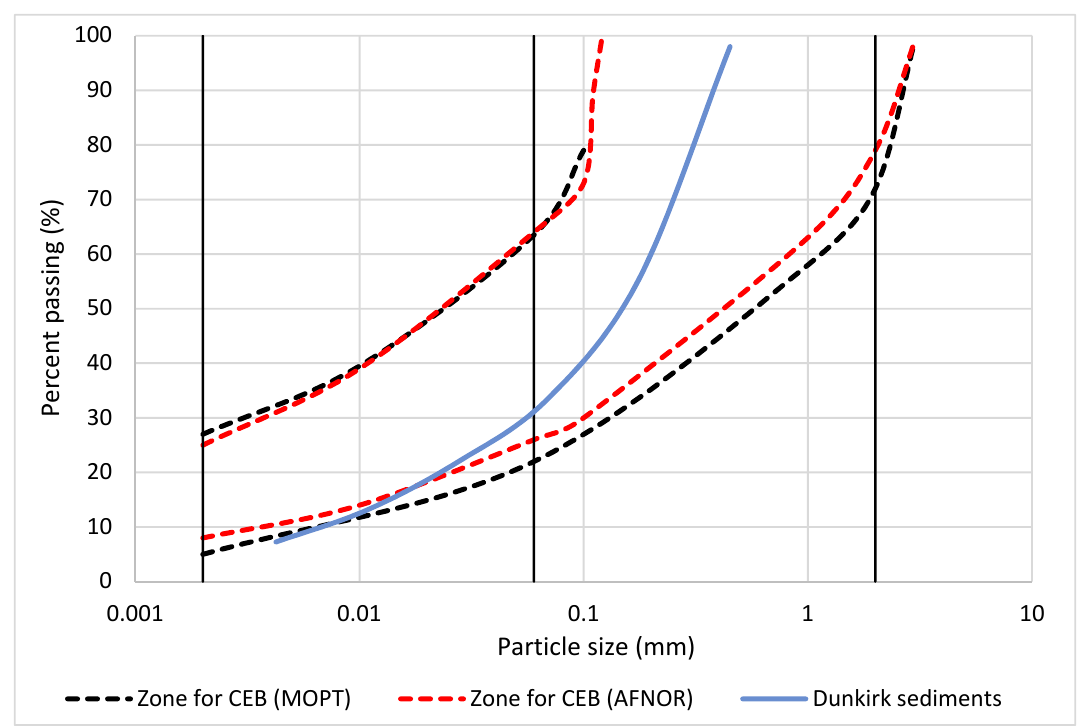
Figure 1. Sediments suitability for bricks. Note: CEB = compressed earth blocks.